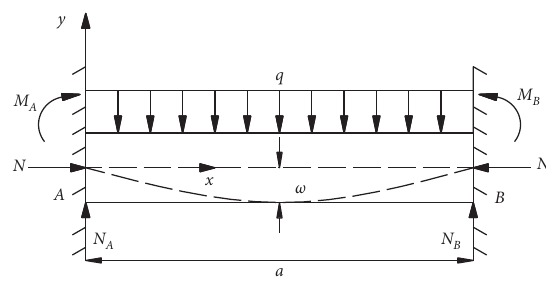
Figure 1: Simplified mechanical model of